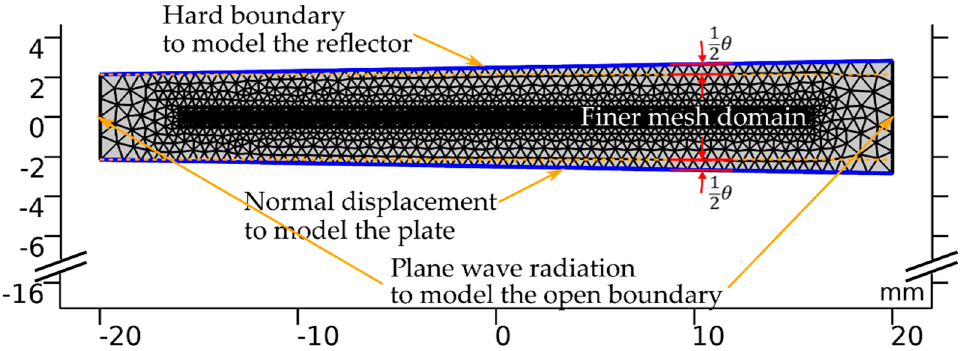
Figure 3. Geometry, mesh, and boundary condition for finite element analysis of plate-reflector model.